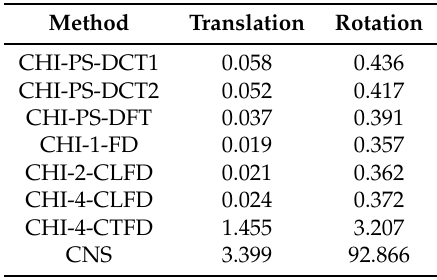
Table 5. Mean execution time (s) for successive image translation and successive image rotation. CHI, cubic Hermite